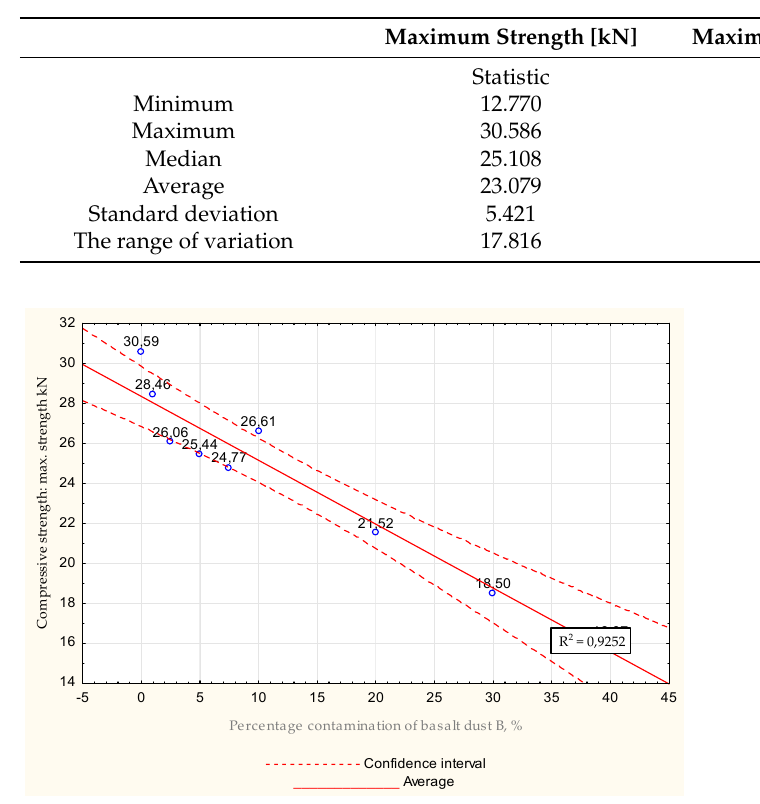
Figure 37. Average values obtained during compressive strength tests after 28 days for water − mix ratio = 0.7, max. strength.